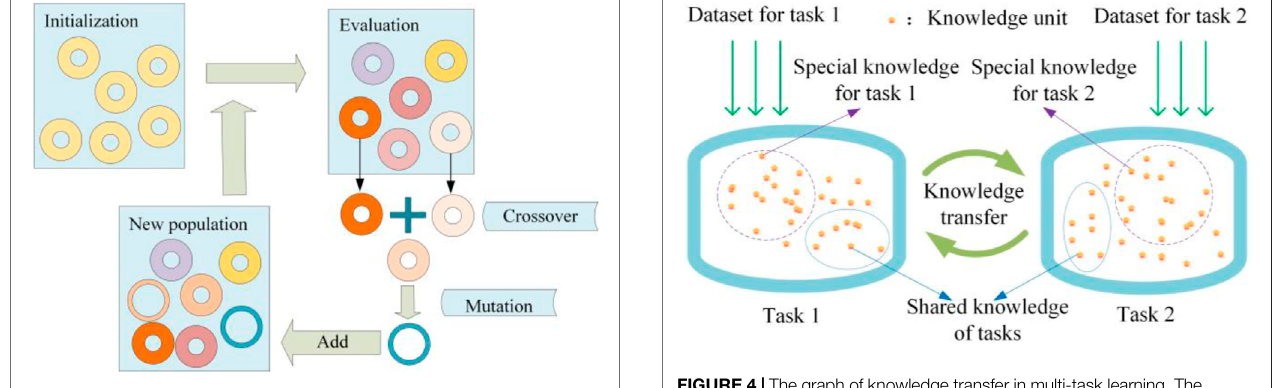
FIGURE 2 | Schematic diagram of differential evolution algorithm.